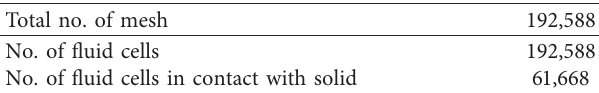
Table 5: Simulation condition of coarse meshing with auto time